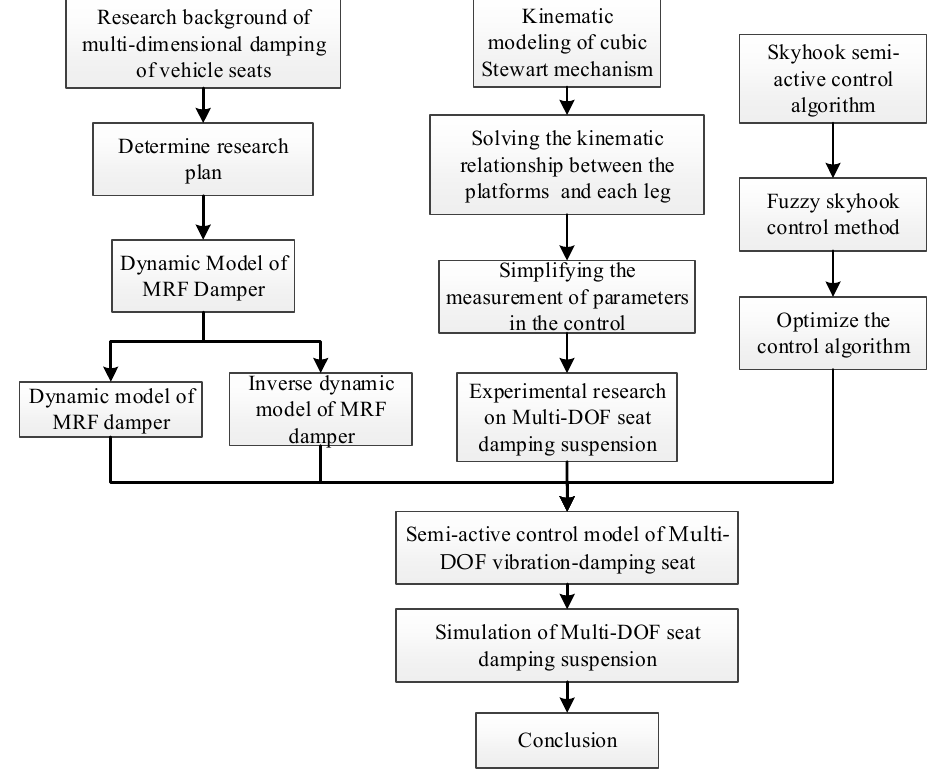
Figure 1. The research route of the article.